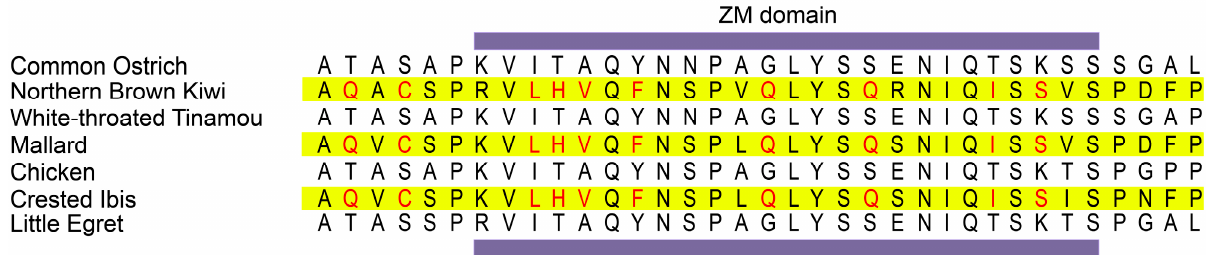
Figure 3. The convergent amino acid substitution sites of PDLIM1 in tactile-foraging birds.